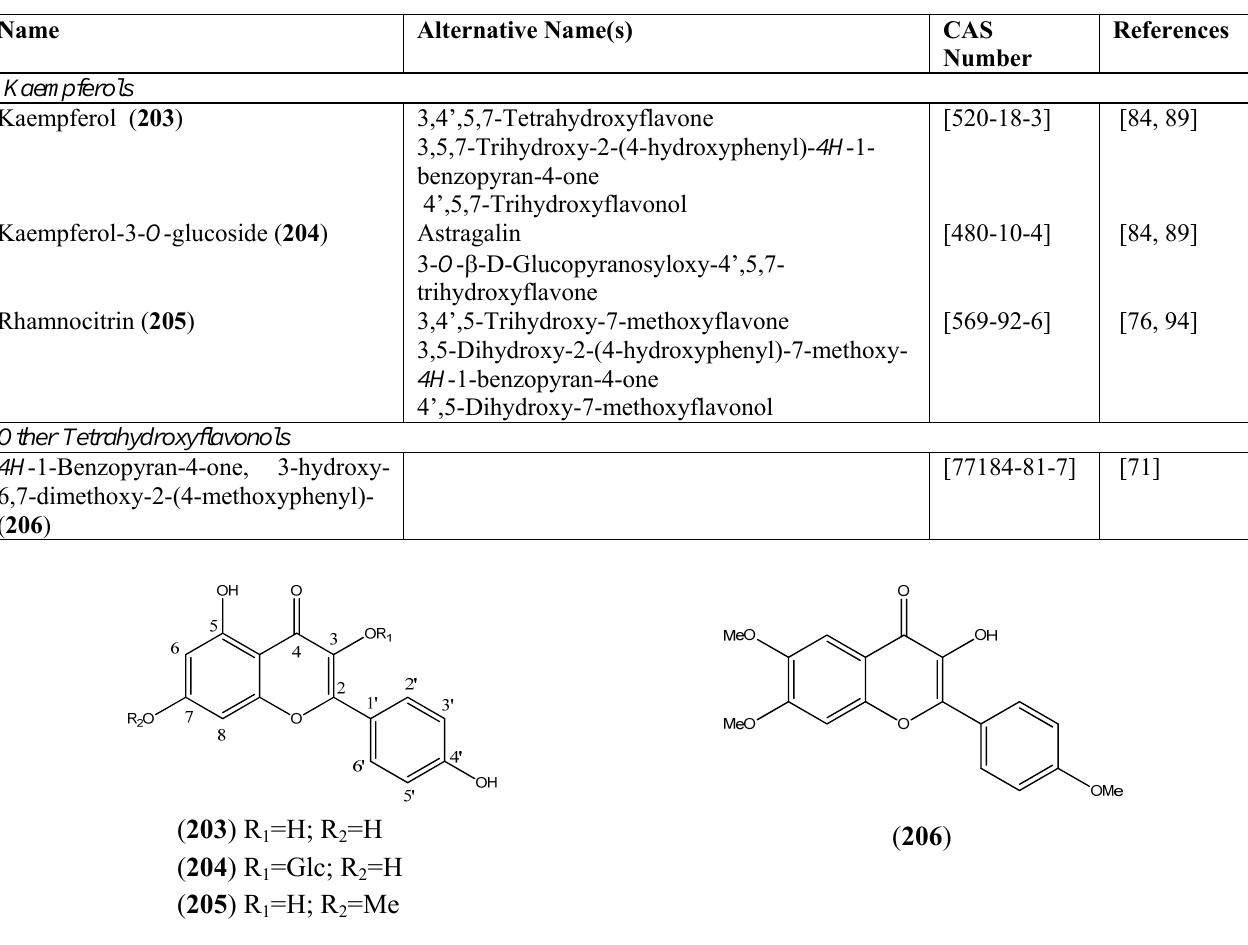
Table 19. Tetrahydroxy